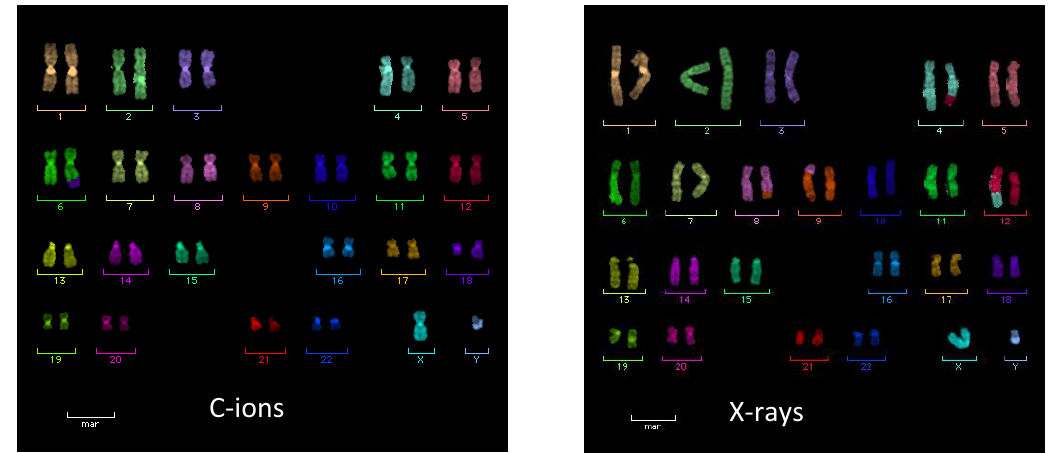
Figure 5. Karyotypes of peripheral blood lymphocytes from two esophageal cancer patients treated with either C-ions (RBE-weighted dose 36 Gy in 10 fractions, radiation field 61 cm 2 ) or X-rays (41.4 Gy in 23 fractions, radiation field 141 cm 2 ) at NIRS-QST, Japan. The C-ion (left) karyotype is 46, XY, t(6;18). The X-ray karyotype (right) is 46, XY, t (4;12), t(8;9). Samples were obtained as described in [74].